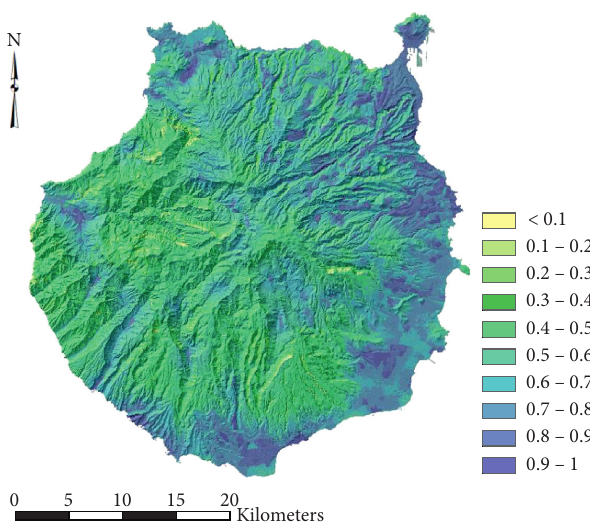
Figure 4: Solar evaluation map.